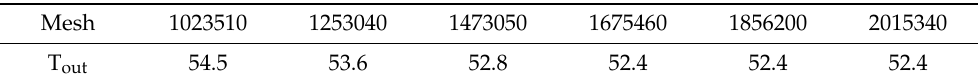
Table 4. The outlet TEM of the Tr-W in the presence of PCM at noon in the summer, when the size of the hole is 17.5 cm.